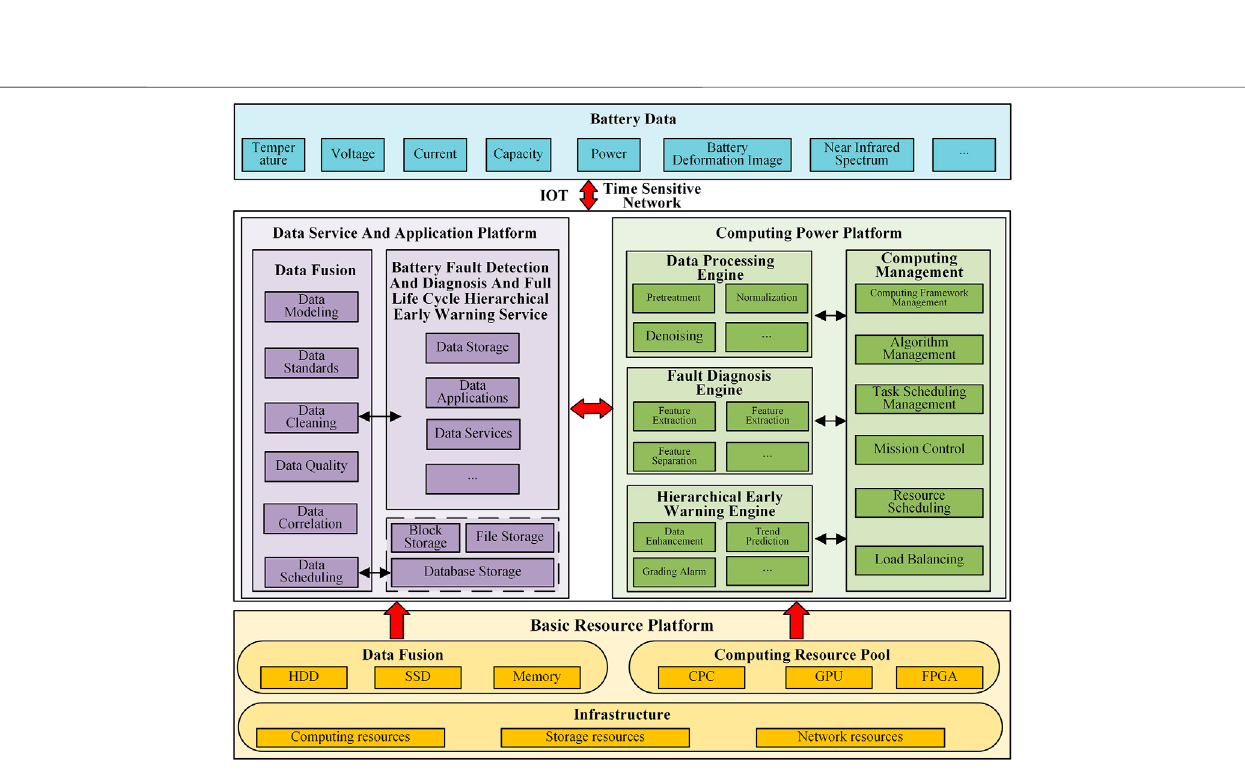
Frontiers in Energy Research |